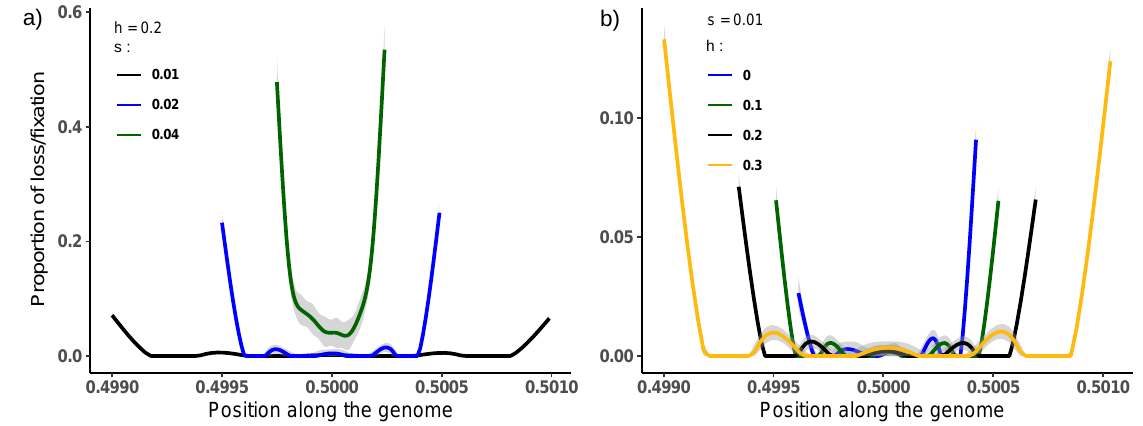
Figure S4 – Effects of levels of selection and dominance on selection dynamics within a POD zone. Observed frequencies of fixation/loss along the POD zone (x values represent the position of the loci along the chromosome) after 4000 generations. The selfing rate σ = 0.95 and linkage ℓ = 10 − 5 M . a) Effects of varying the coefficient of selection at load loci ( s = 0.01, 0.02 and 0.04 , corresponding to n L = 100, 50 and 25 loci) with dominance fixed at h = 0.2 and s H = 0.45 . b) Effects of varying dominance ( h = 0, 0.1, 0.2 and 0.5 with n L = 60, 75, 100 and 150 ) with selection fixed at s = 0.01